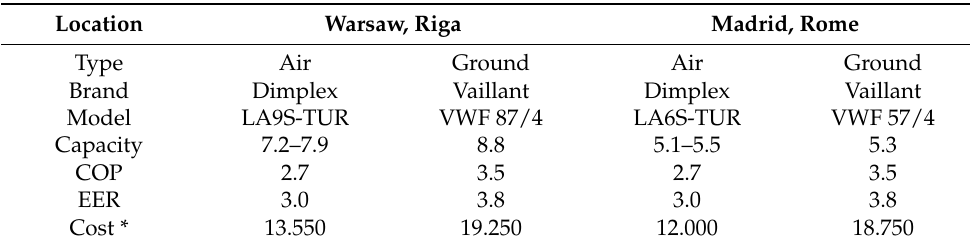
Table 3. Data of the selected heat